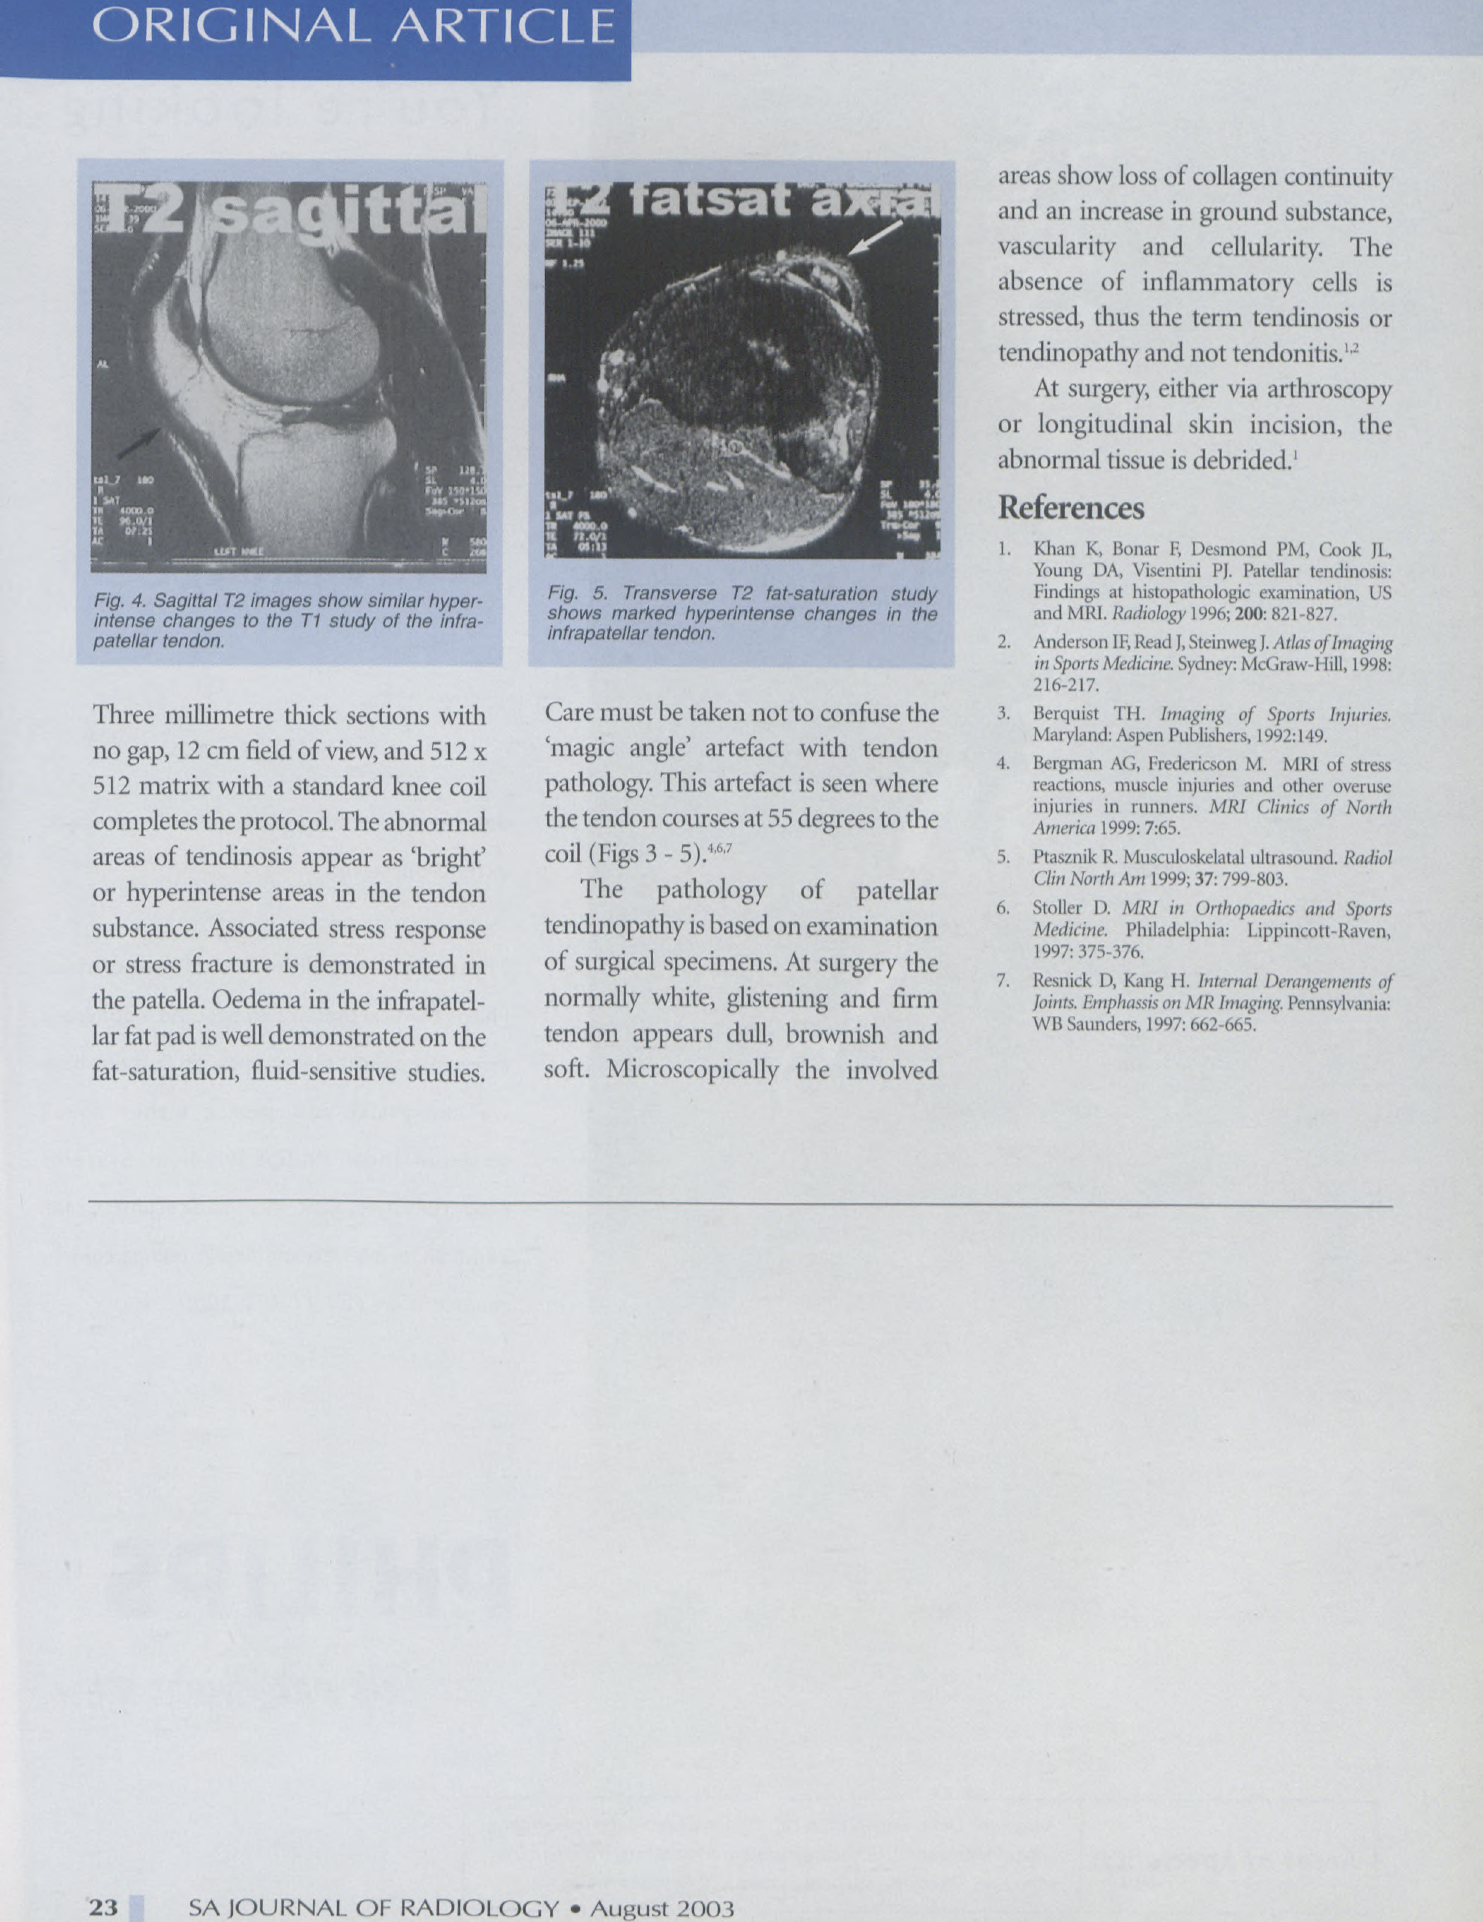
Fig. 4. Sagittal T2 images show similar hyper- intense changes to the Tt study of the infra- patel/ar tendon.